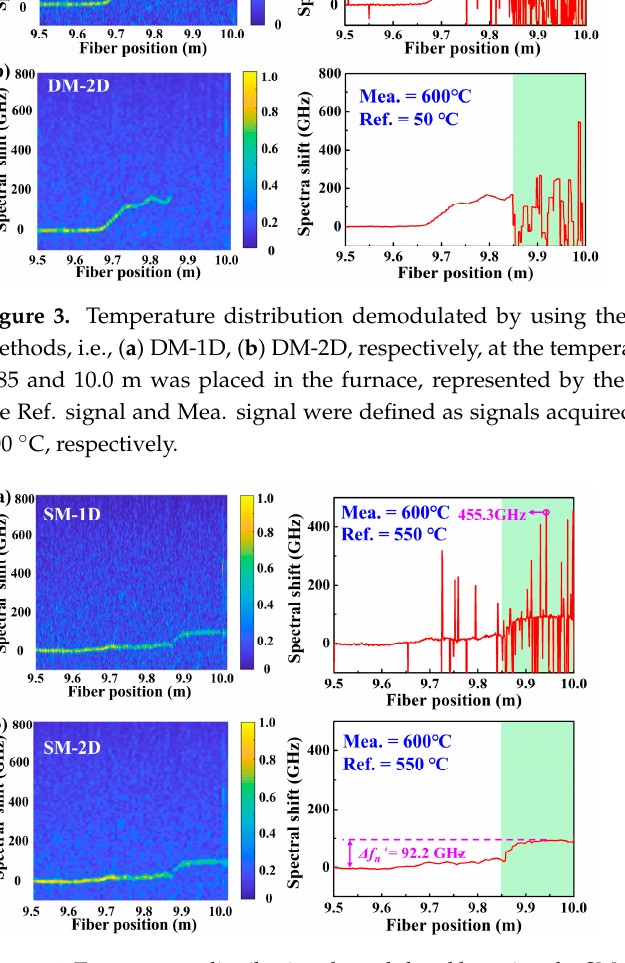
Figure 4. Temperature distribution demodulated by using the SM combined with 1D and 2D method, i.e., ( a ) SM-1D, ( b ) SM-2D, respectively, at the temperature of 600 °C. Note that, in the SM, the Ref. signal and Mea. signal was defined as signals acquired at the temperatures of 550 °C and 600 °C, respectively.